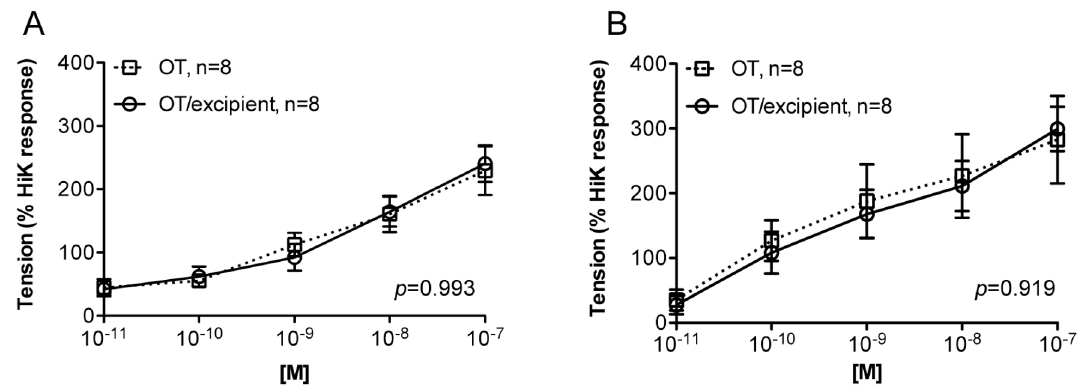
Figure 3. Ex vivo assessment of oxytocin induced uterine smooth muscle contractions. Effects of applied oxytocin on smooth muscle contractility ex vivo using (A) human (n=8) and (B) ovine (n=8) uterine tissue samples. Contraction was normalized as % of the response to high potassium (HiK) in PSS. doi: